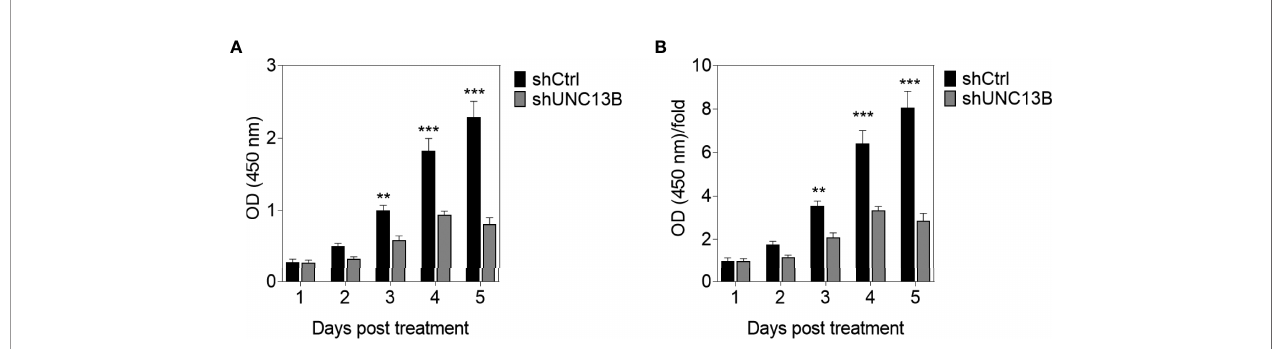
FIGURE 2 | CCK-8 evaluation of the in fl uence of UNC13B knockdown on the proliferation of arsenic trioxide (ATO)-resistant K-562 cells. (A) Optical density (OD) value of the cells measured at 450 nm and tested via CCK-8 assay in different timepoints. (B) OD/fold of (A) . ** p < 0.01, *** p <